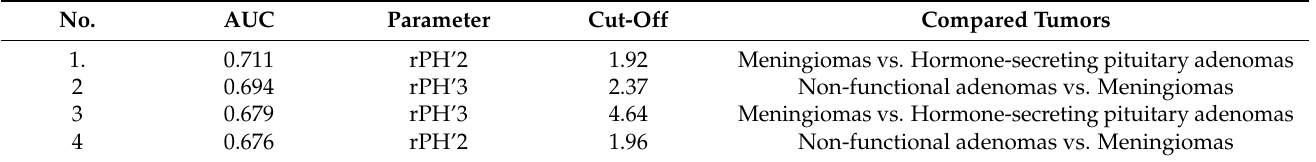
Table 3. Analysis of receiver operating characteristic (ROC) curves for rPH